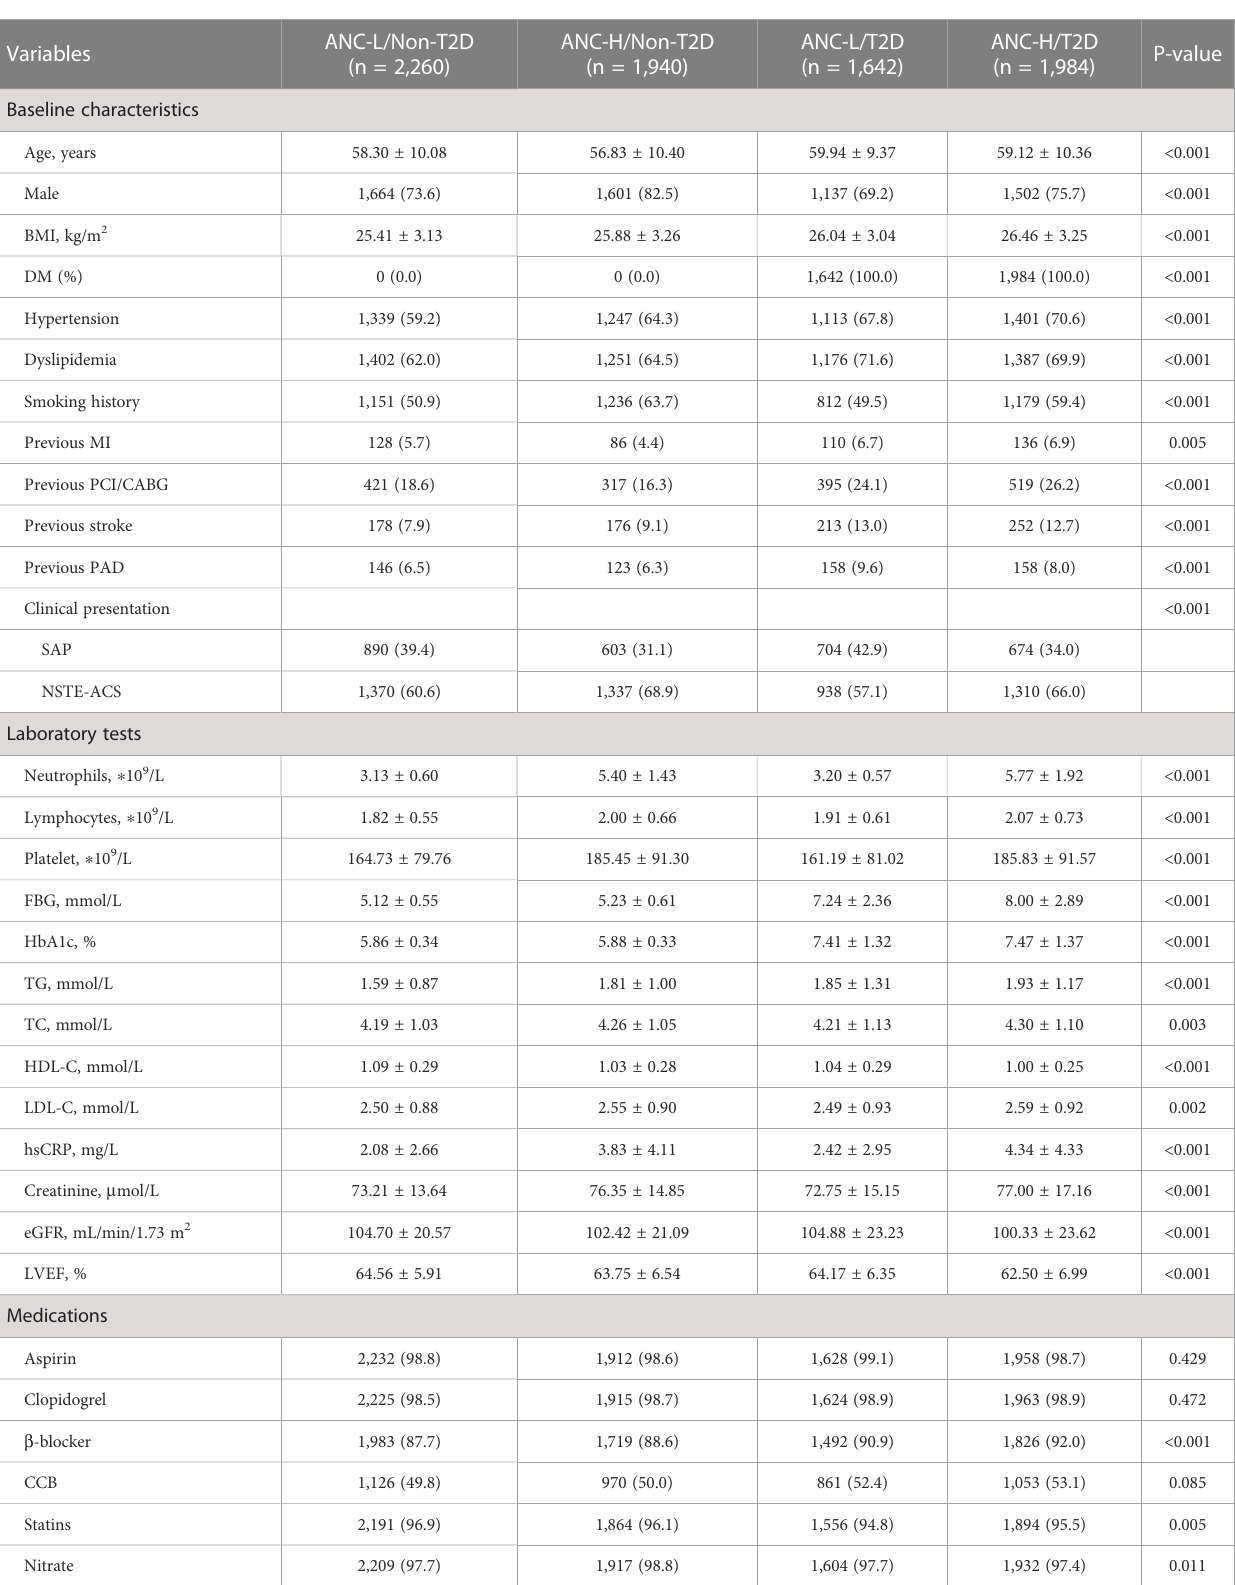
TABLE 2 Baseline characteristics for diabetic or non-diabetic patients with different ANC